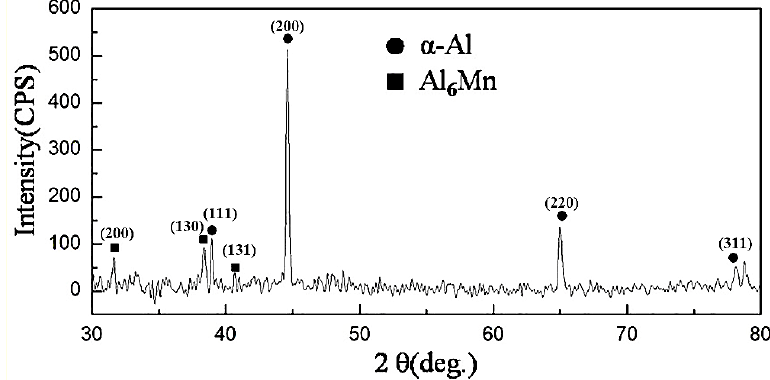
Figure 3. XRD pattern of suction casting Al–6 wt.% Mn alloy.